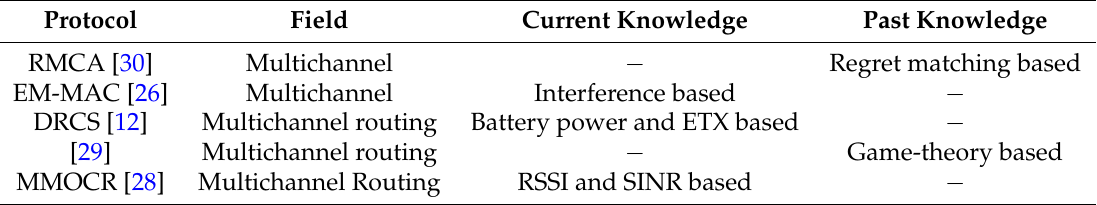
Table 2. Summary of related protocols reviewed. ETX, expected number of transmissions.